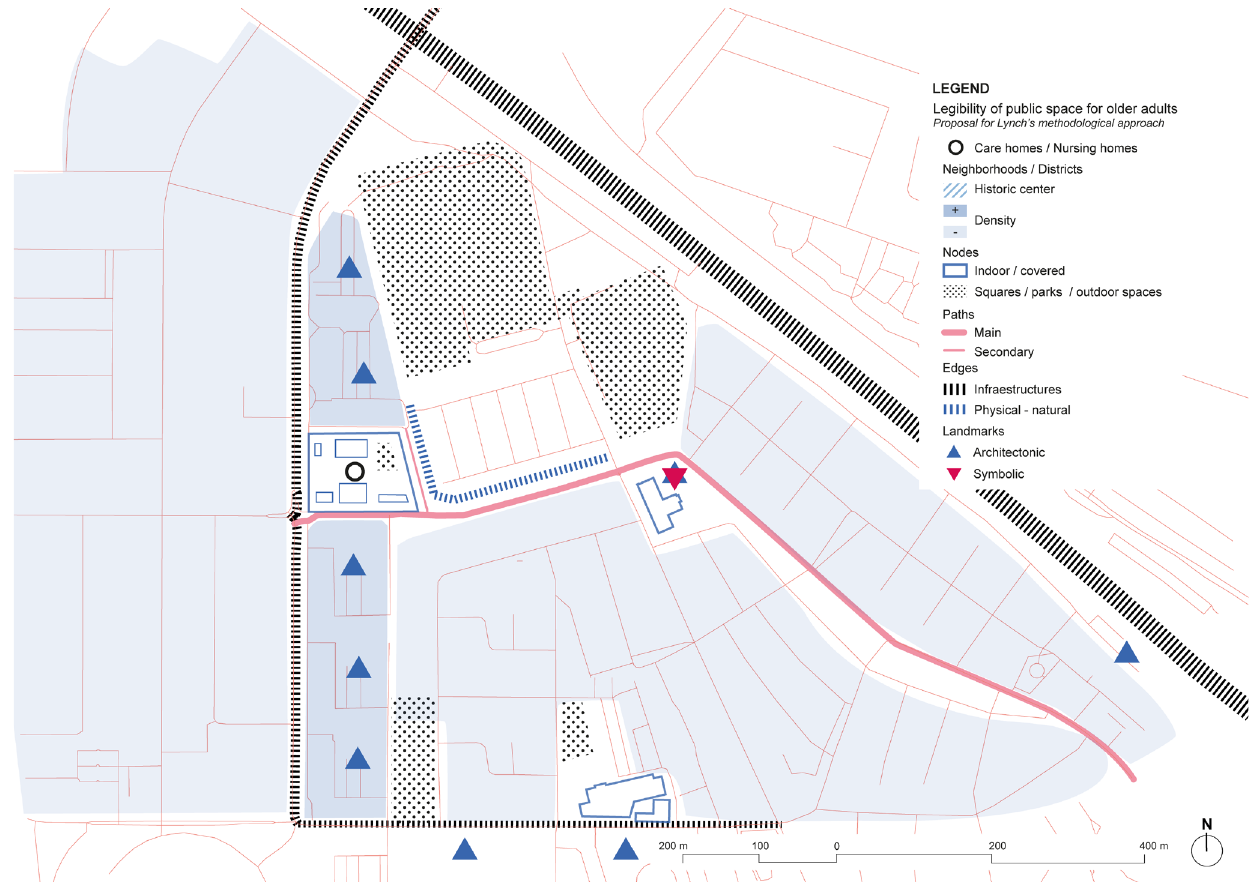
Figure 23. De Hogeweyk surroundings’ scheme based on Lynch’s theory. Source: Own elabora- tion.